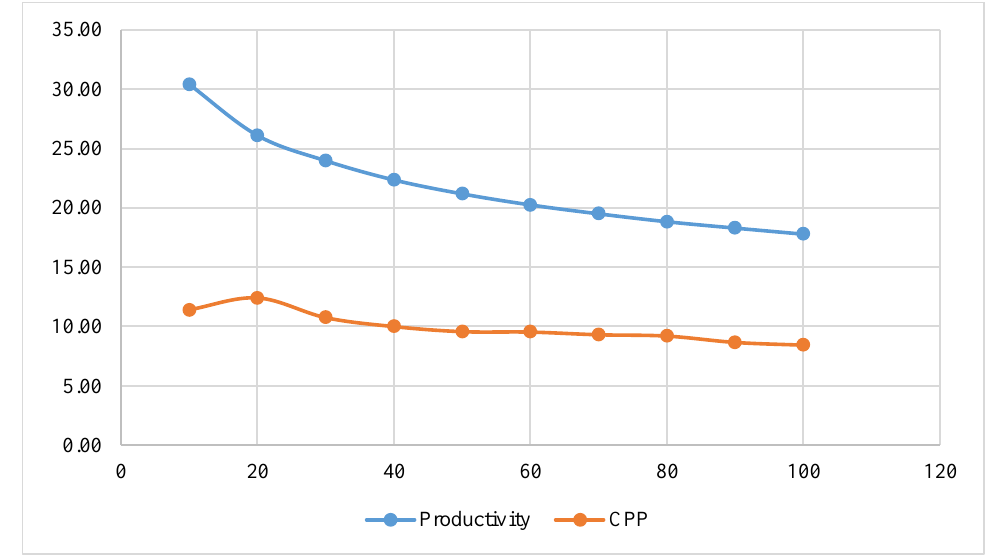
Figure 5. Top 100 Authors in Big Data Research: Quantity vs Quality